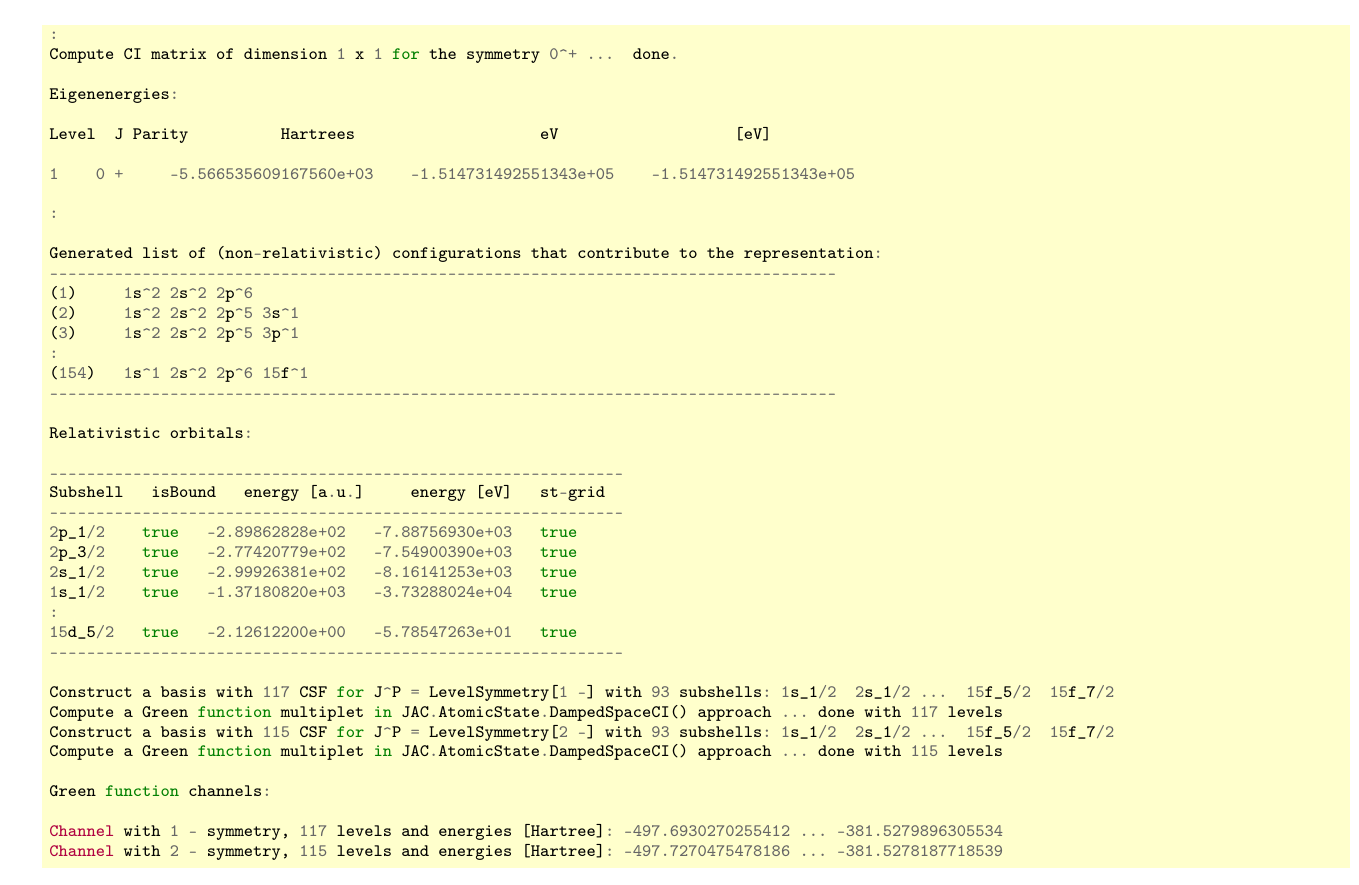
Figure 4. Selected printout from the example in Section 3.3. Table 3. Excitation energies E ν − E o of the seven low-lying levels from the Green function channel J = 1 − . Energies are shown relative to the 1 s 2 2 s 2 2 p 6 1 S 0 ground level and are compared with data available from the NIST Atomic Spectra Database [59]. Results are shown for three computational models. The use of a (I) diagonal CSF basis with n ( max ) = 15 and (cid:96) = [ 0,1,2 ] ; (II) the same but for the full Dirac-Coulomb Hamiltonian; and (III) the Dirac-Coulomb Hamiltonian but by including additional (double) excitations with regard to the 1 s 2 2 s 2 2 p 6 reference configuration. See text